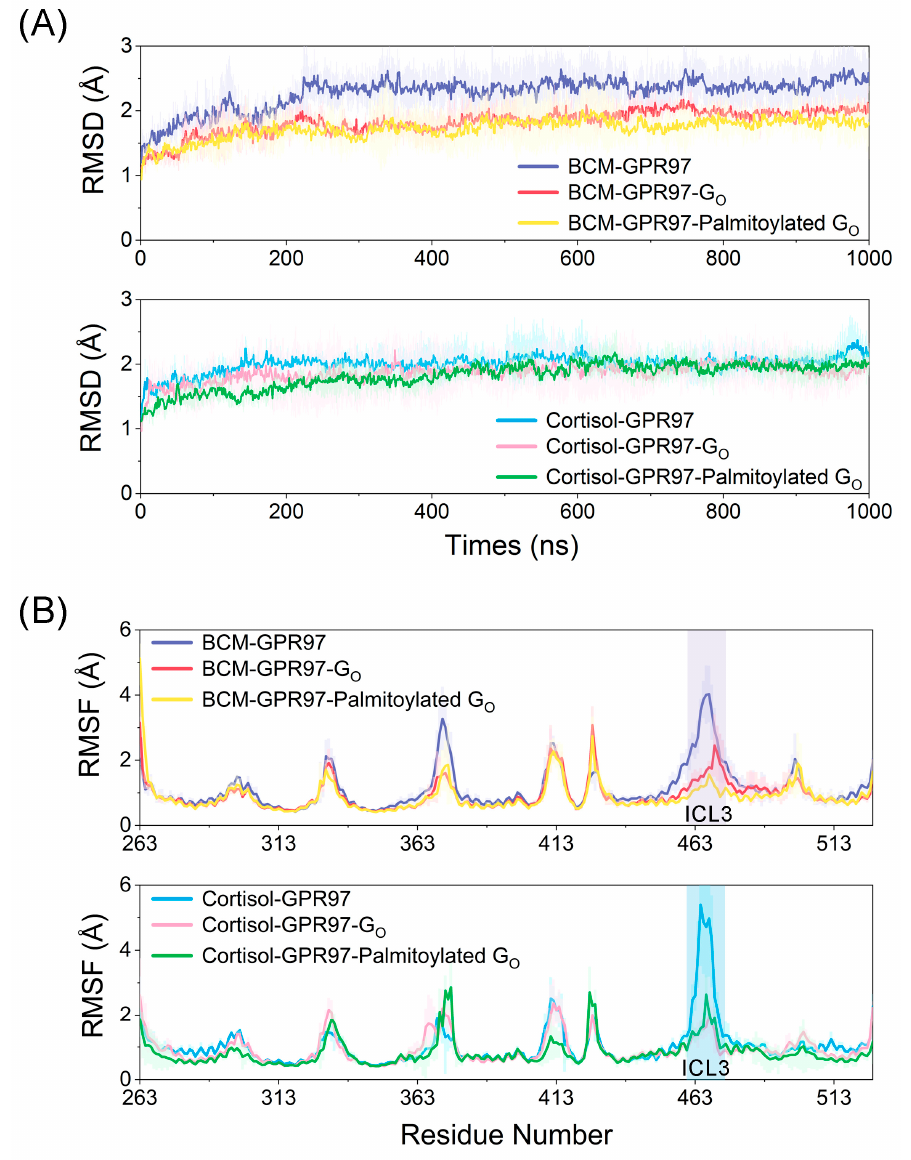
Figure 2. ( A ) The C α RMSD of GPR97 in the BCM–GPR97 (purple), BCM–GPR97–G o (red), BCM– GPR97–palmitoylated G o (yellow), cortisol–GPR97 (blue), cortisol–GPR97–G o (pink), and cortisol–